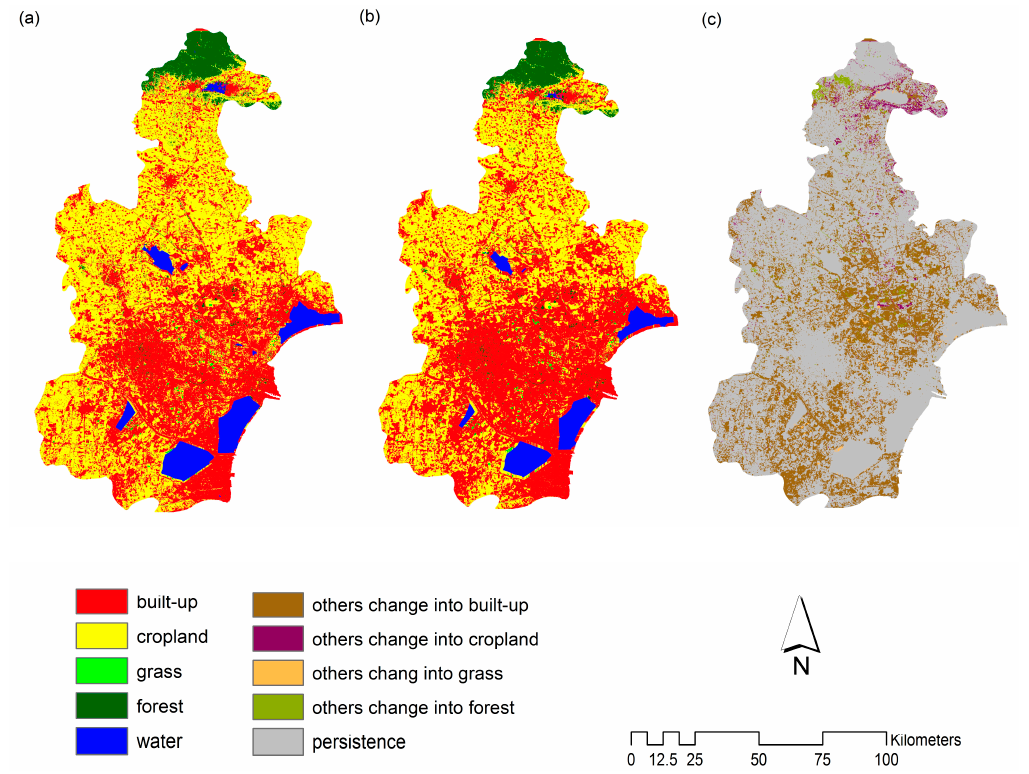
Figure 6. Simulation LULC in 2025 ( a ) and in 2035 ( b ), and change map 2025–2035 ( c ).